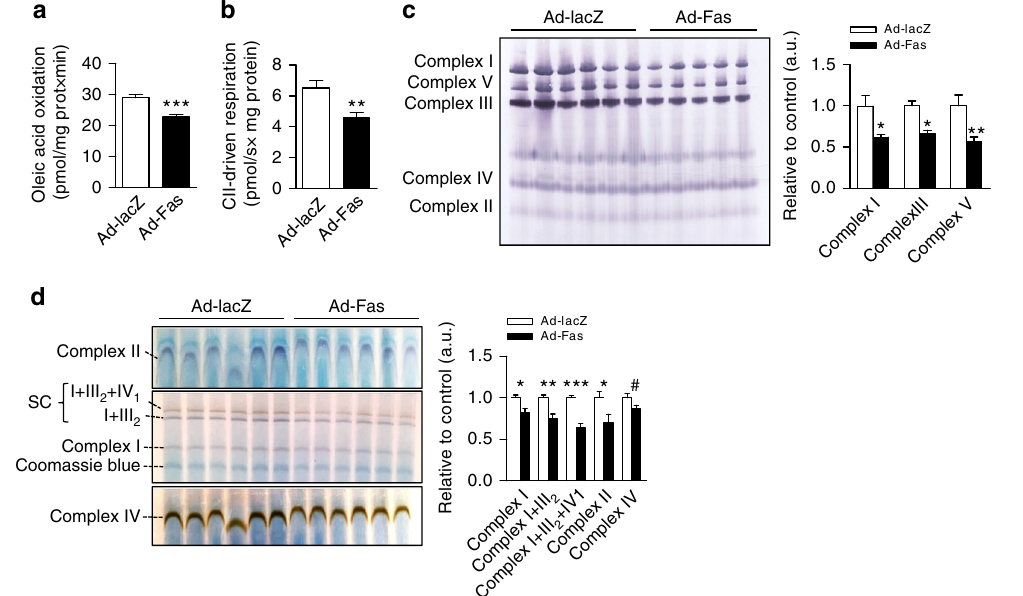
Fig. 3 Fas impacts on hepatic mitochondrial function and fatty acid oxidation. a Oleic acid oxidation rate in liver homogenates of mice injected with adenovirus expressing Fas (Ad-Fas) or lacZ (Ad-lacZ), n = 7. b Respirometry analysis of complex II (CII)-driven respiration in liver tissue from Ad-Fas ( n = 11) and Ad-lacZ ( n = 16) mice. c Blue native (BN) polyacrylamide gel electrophoresis (PAGE) and d in-gel activity assay using isolated mitochondria from liver of Ad-Fas ( n = 5 and 6 respectively) and Ad-lacZ ( n = 6) mice. Quanti fi cation of individual band was performed using ImageJ. Values are expressed as mean ± s.e.m.; * p < 0.05, ** p < 0.01, *** p < 0.001, and # p = 0.08 (Student ’ s t -test)